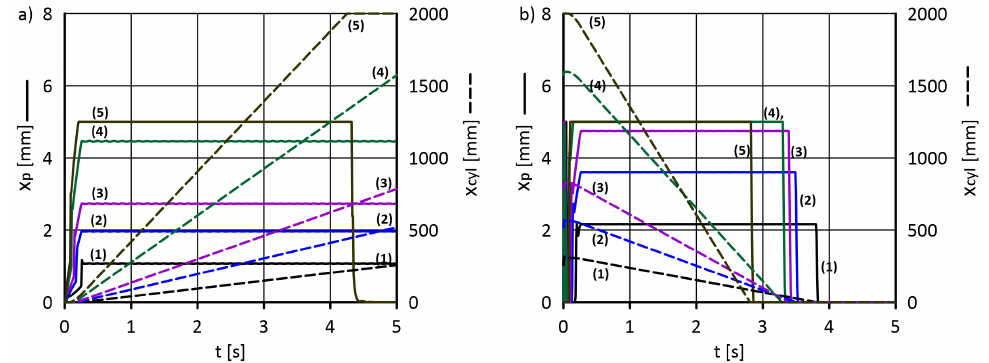
Figure 12. Check valve gap width x p ( t ) and hydraulic actuator displacement c cyl ( t ) for the reduced stiffness k spr = k 1 = 24.6 N mm − 1 ; ( a ) A-B flow direction, ( b ) B-A flow